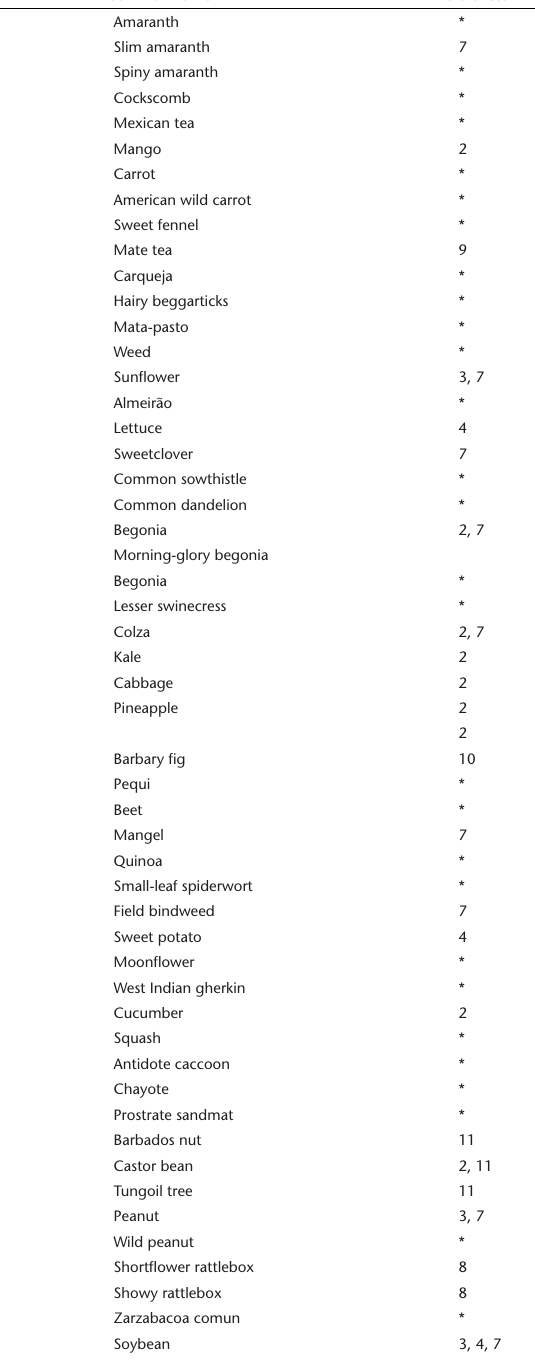
4. Checklist of natural host plants of Spodoptera cosmioides larvae recorded in several bibliographic sources of South America and new records from Rio Grande do Sul State, Brazil, largely based on the mountainous region from two population outbreaks, during the springs of 1997 and 2004. Beta vulgaris Linn. Beet * Beta vulgaris Linn. var. Rapacea Koch Mangel 7 Commelinaceae Tradescantia fluminensis Vell. Small-leaf spiderwort * Convolvulaceae Convolvulus arvensis Linn. Field bindweed 7 Ipomoea batatas (Linn.) Lam. Sweet potato 4 Ipomoea grandiflora Linn. Moonflower * Cucurbitaceae Cucumis anguria Linn. West Indian gherkin * Cucumis sativus Linn. Cucumber 2 Fevillea cordifolia Linn. Antidote caccoon * Sechium edule (Jacq.) Sw. Chayote * Euphorbiaceae Chamaesyce prostrata (Aiton) Small Prostrate sandmat * Jatropha curcas Linn. Barbados nut 11 Ricinus communis Linn. Castor bean 2, 11 Vernicia fordii (Hemsl.) Airy-Shaw Tungoil tree 11 Fabaceae Peanut 3, 7 Crotalaria spectabilis Roth. Showy rattlebox 8 Desmodium incanum DC. Zarzabacoa comun * Glycine max (Linn.) Merril. Soybean 3, 4, 7